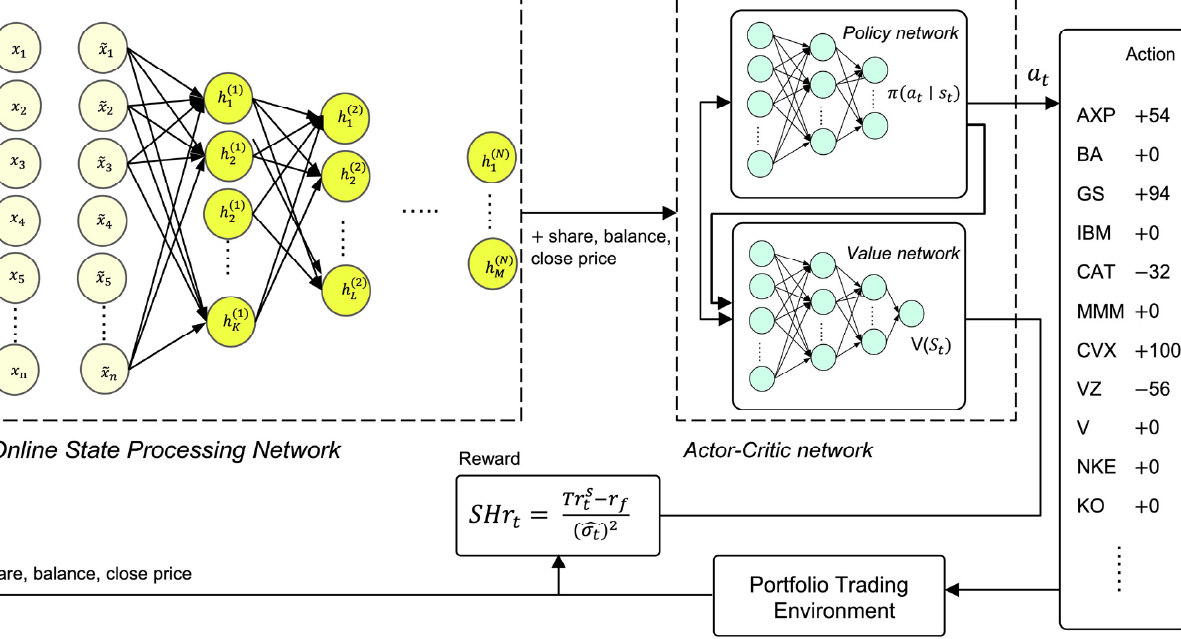
Figure 2. Overview of the proposed model.